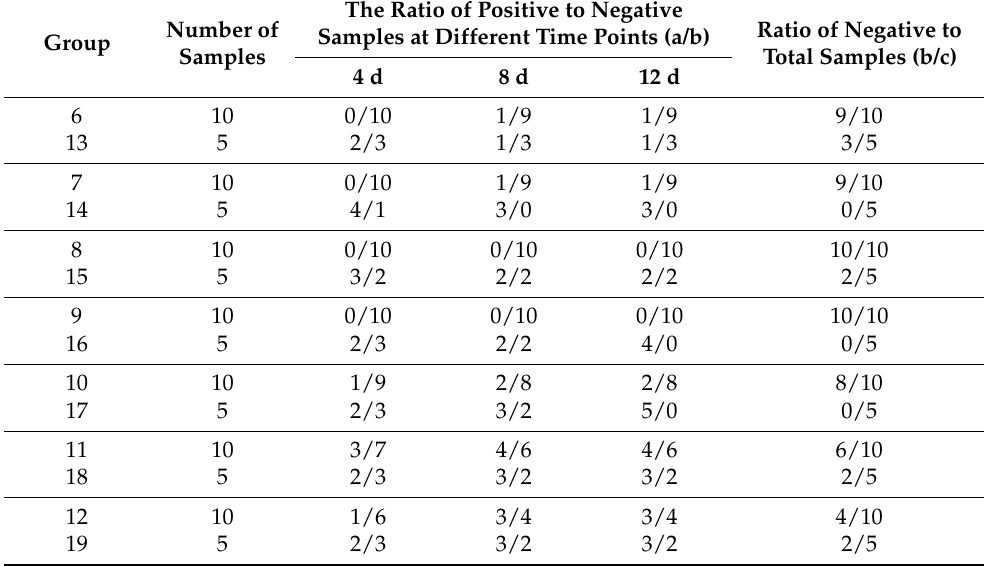
Total Samples (b/c) Ratio of Negative to